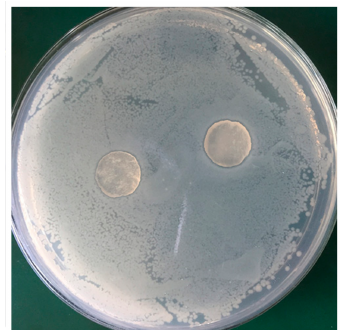
Figure 5. Non-leaching e ff ect of composite hydrogel observed using a ring di ff usion method.